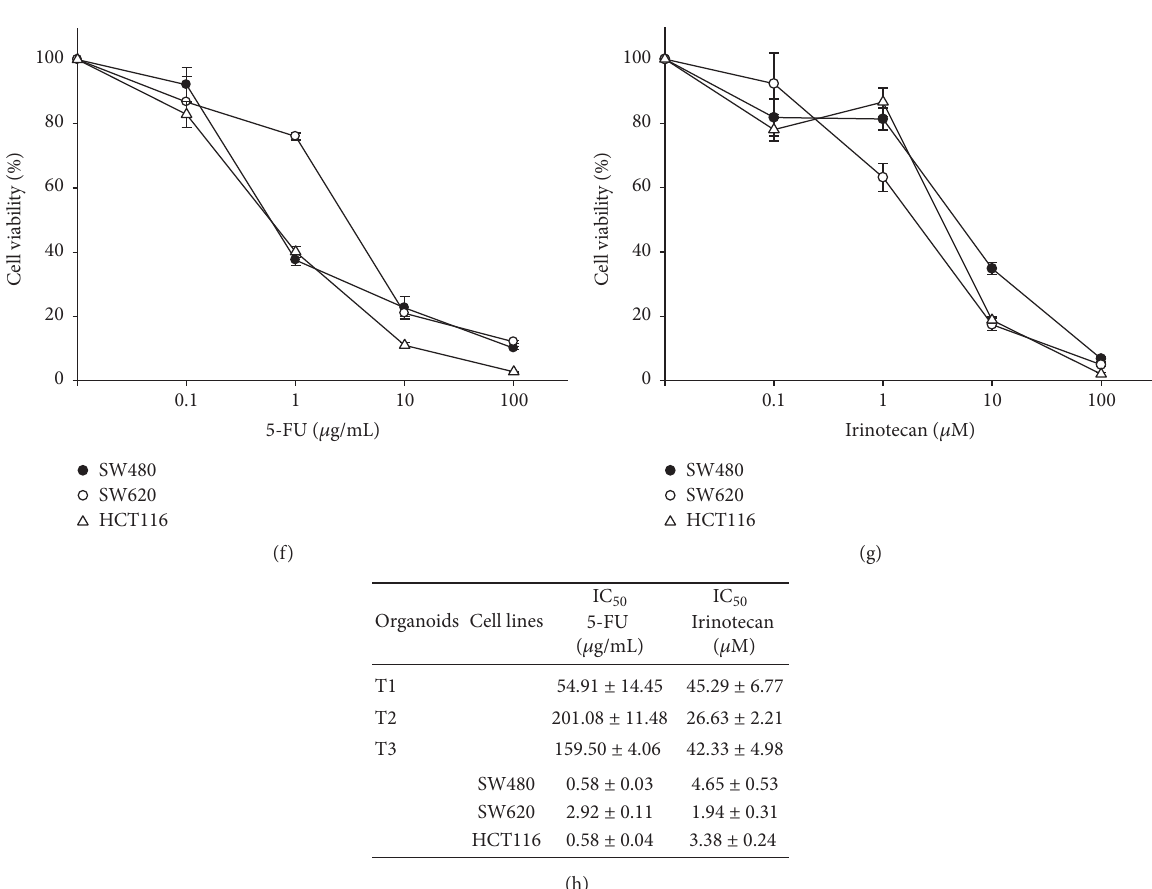
Figure 4: Comparison of responsiveness to anticancer drugs between human ALI tumor colorectal organoids and 2D cultured colorectal cancer cell lines. Schematic experimental design of an anticancer drug treatment for human ALI tumor colorectal organoids from three patients and colorectal cancer cell lines (a). After tumor ALI organoids were seeded into Matrigel, they were treated with 5-fluorouracil (5- FU) ((b), (c) n = 5 each for three patients (T1, T2, and T3); 10–300 𝜇 g/mL) or Irinotecan ((d), (e) n = 5 each for three patients (T1, T2, and T3); 10–300 𝜇 M) for 6 days. Representative phase contrast images of tumor organoids treated with 5-FU or Irinotecan are shown (b, d). Scale bar: 200 𝜇 m. Cell viability was determined using Alamar Blue assay and 100% represents cell viability of each control (c, e). Effects of treatment with anticancer drugs on colorectal cancer cell lines, SW480, SW620, and HCT116. After cells were seeded into Matrigel, they were treated with 5-FU ((f) n = 5, each cell line, 0.1–100 𝜇 g/mL) or Irinotecan ((g) n = 5, each cell line, 0.1–100 𝜇 M) for 3 days. Cell viability was determined using an Alamar Blue assay and 100% represents cell viability of each control (f, g). Half maximal inhibitory concentration (IC 50 ) values